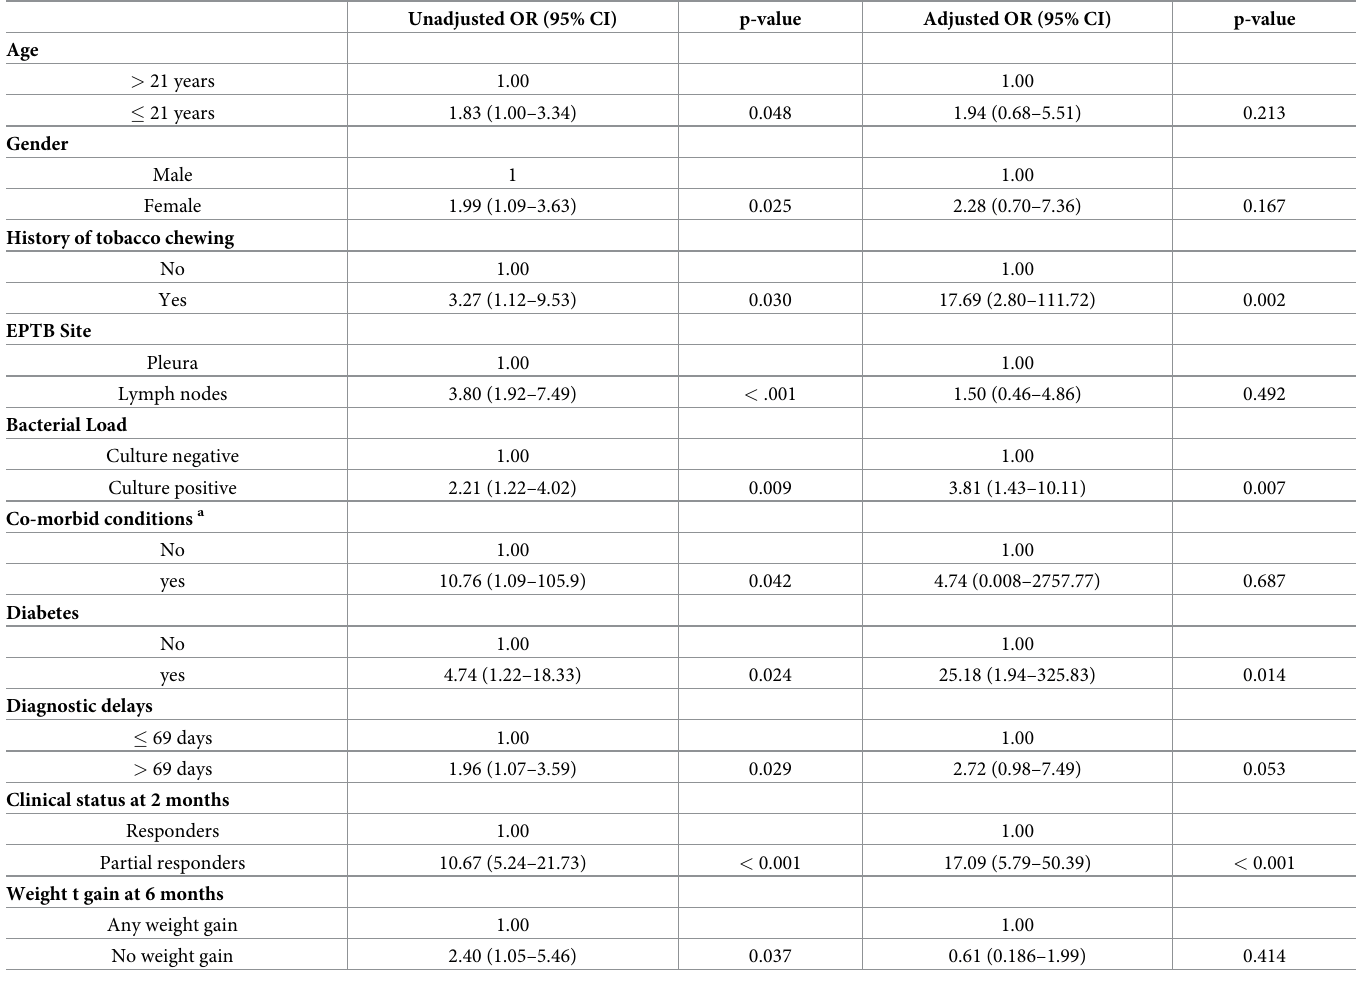
Table 3. Multivariable logistic regression model for predictors of extended TB